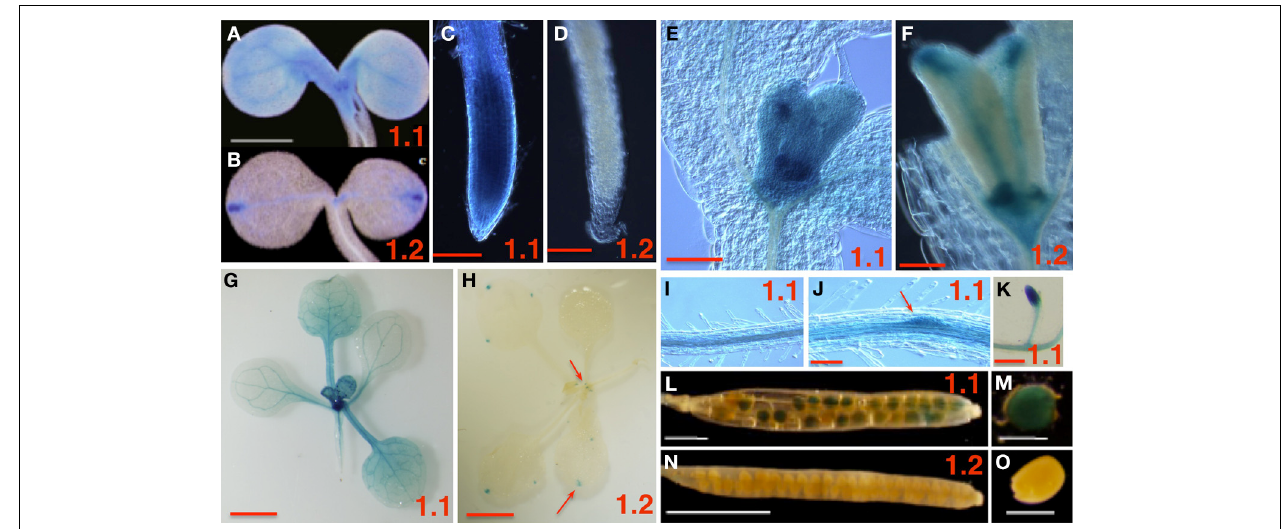
FIGURE 1 | Spatial Expression Patterns of SnRK1.1 and SnRK1.2 Genes. The promoters from SnRK1.1 (1.1 shown in A,C,E,G,I–M ) or SnRK1.2 (1.2 shown in B,D,F,H,N,O ) were used to drive GUS expression in transgenic plants. (A–F,I,J) are from plants grown on MS agar with no added sugar, and (G,H,L–O) are from soil-grown plants. (A,B) 5d